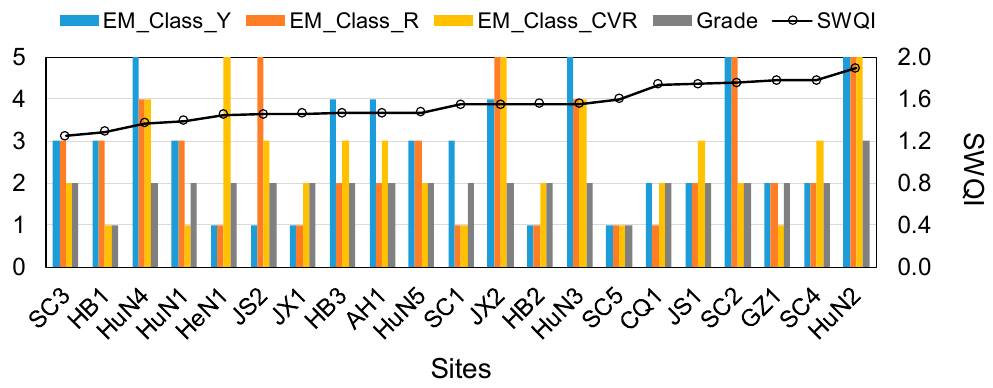
Figure 7. Classifications of three EM clustering algorithms, water quality grades, and SWQIs of the 21 YRB sites for 2016. Note: EM_Class_Y represents EM clusters using yearly data; EM_Class_R represents EM clusters using yearly SWQI (i)s and ratios of unpolluted weeks; EM_Class_CVR represents EM clusters using ratios of unpolluted weeks and CVs of weekly data.